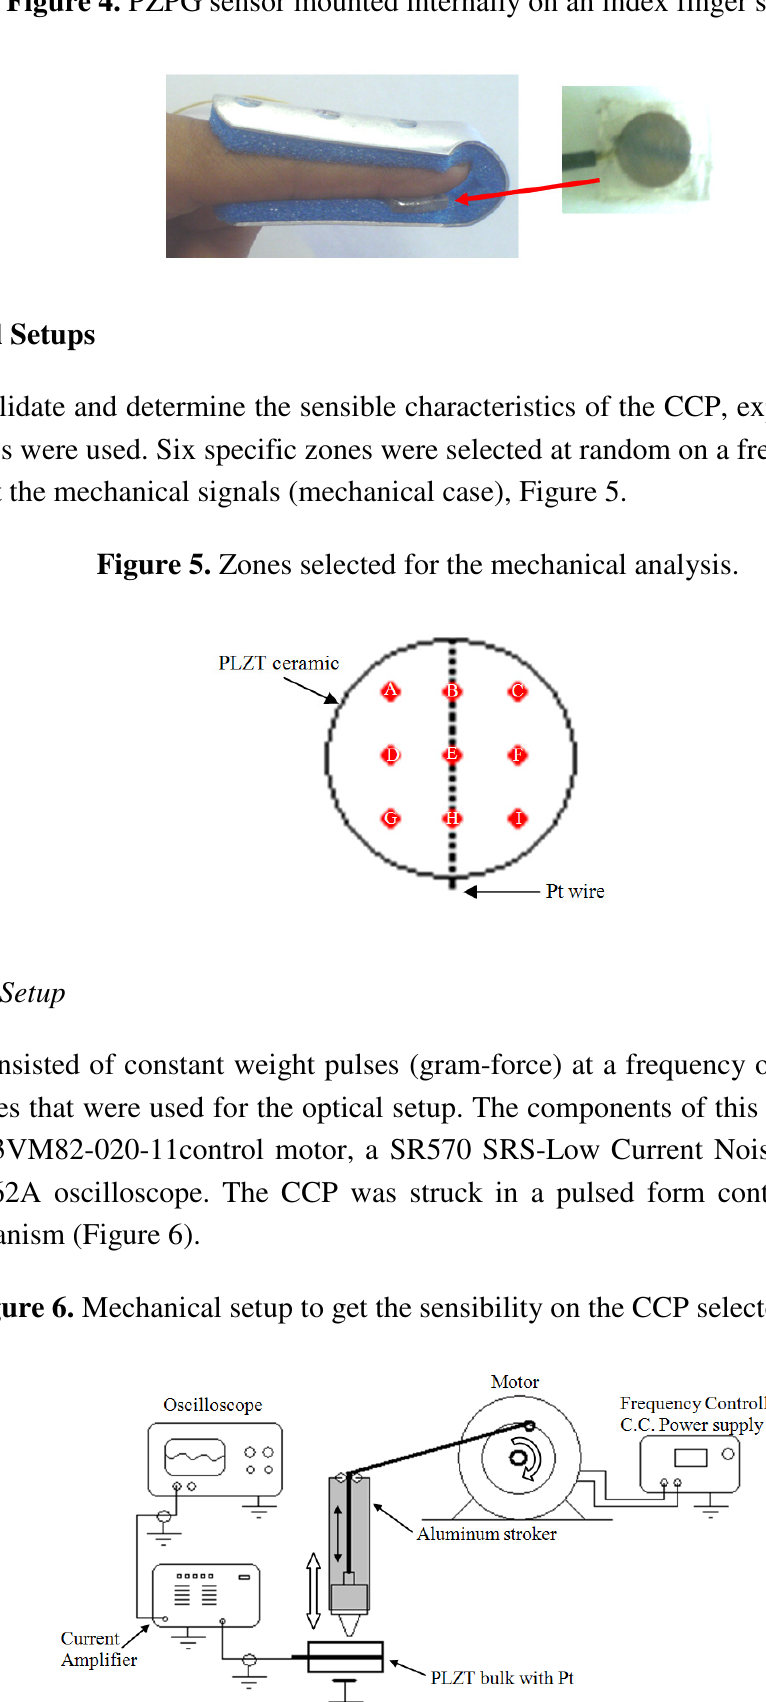
Figure 4. PZPG sensor mounted internally on an index finger splint.